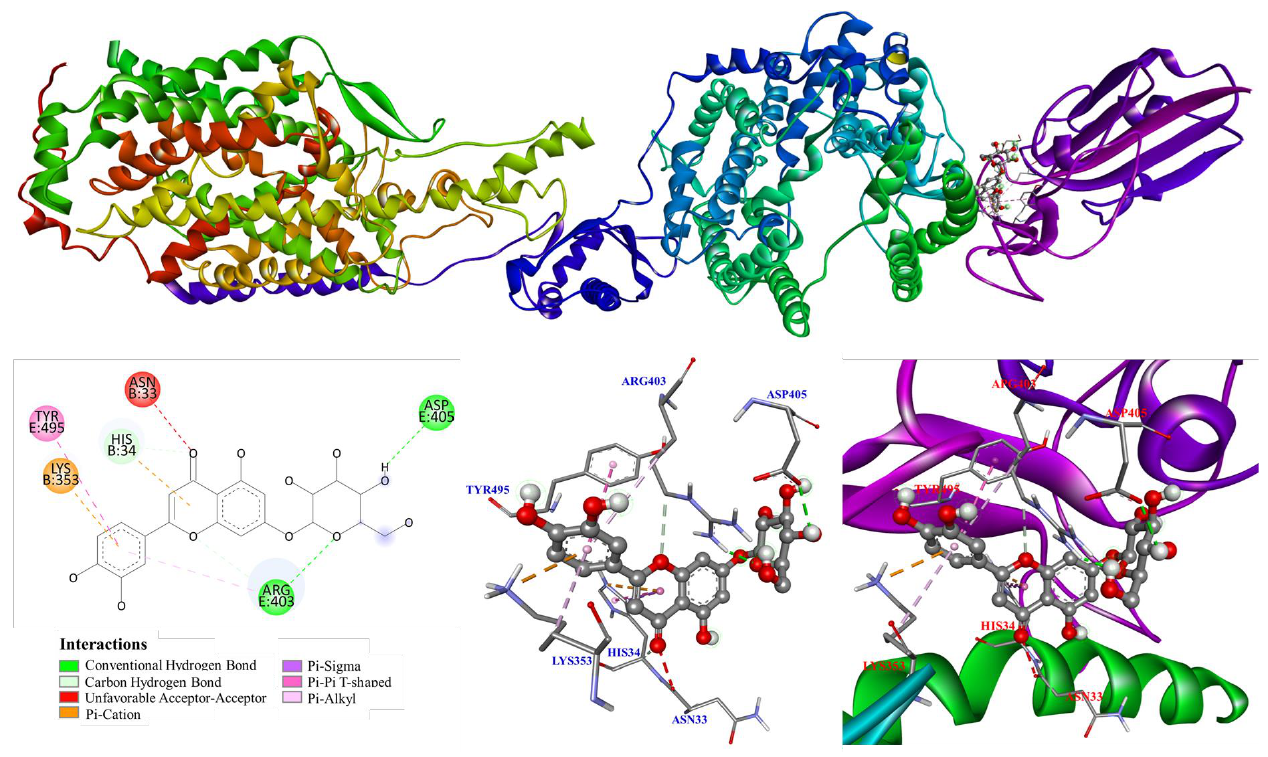
Figure 6. Interactions of luteolin-7-O-glucoside between SARS-CoV-2-RBD and ACE2 in silico.